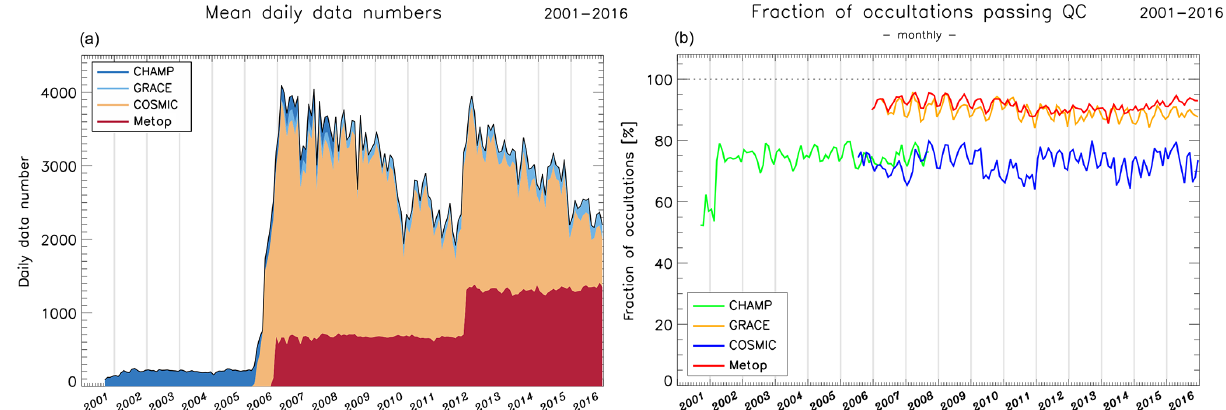
Figure 1. (a) Mean daily number of occultation events used in the generation of the ROM SAF climate data record, based on the four RO missions (CHAMP, GRACE, COSMIC, and Metop). (b) Fraction of occultations available for the generation of gridded monthly mean data, after quality screening of the input profile